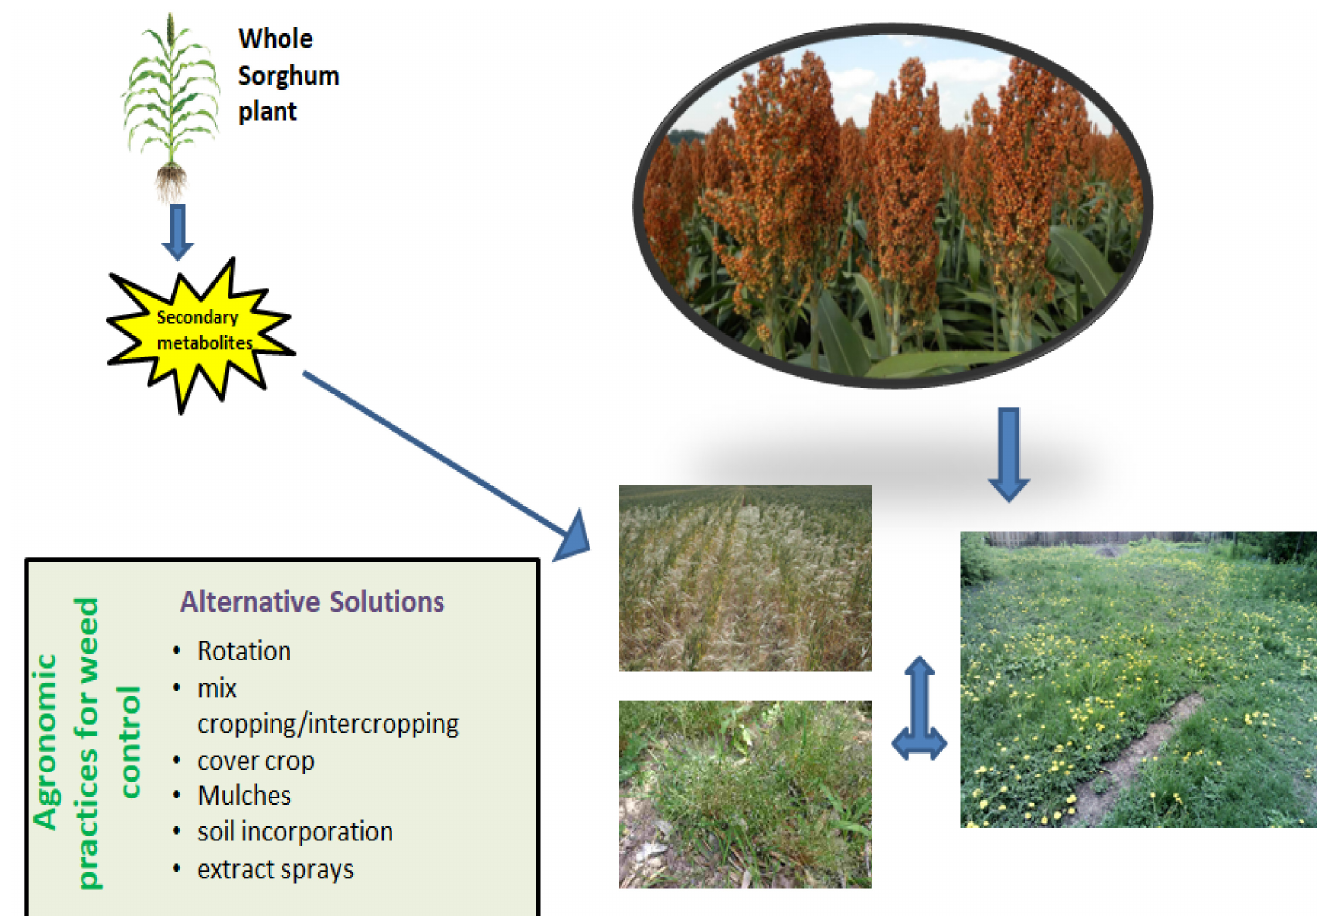
Figure 1. An illustration to demonstrate how sorghum can impact through several biological control practices on differ- ent weeds.